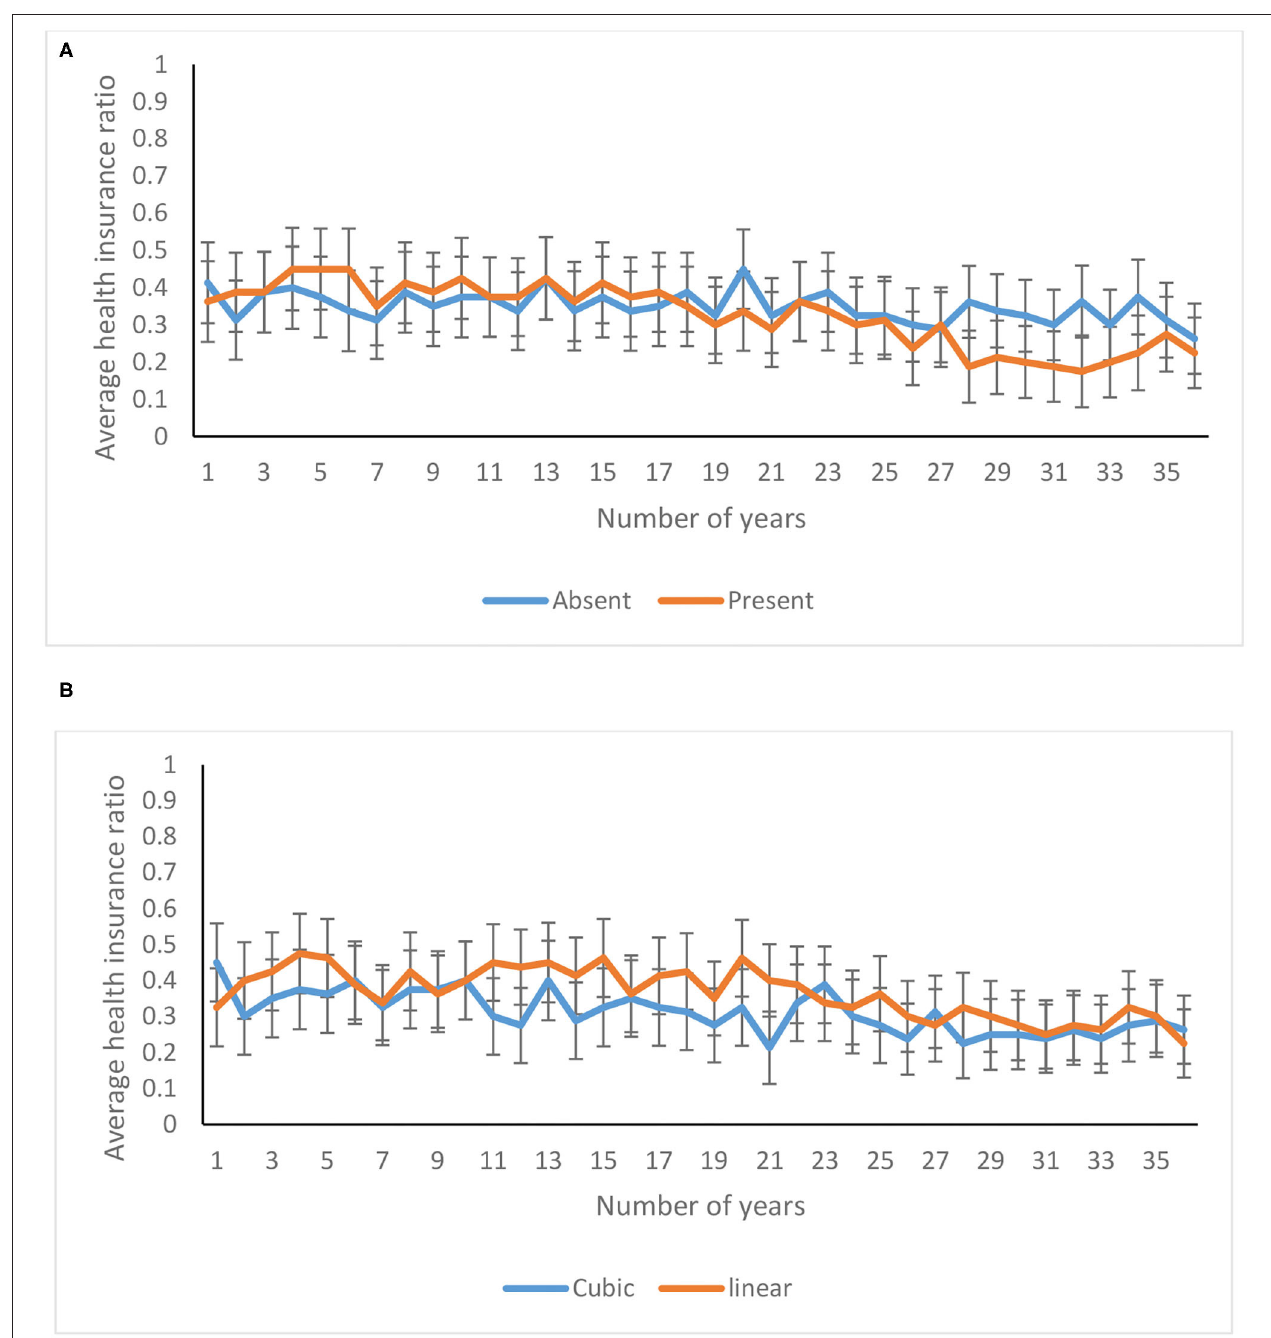
FIGURE 12 | Average health insurance ratio over years in (A) feedback-present and absent conditions, and in (B) cubic and linear probability conditions. The error bars show 95% CI around the point